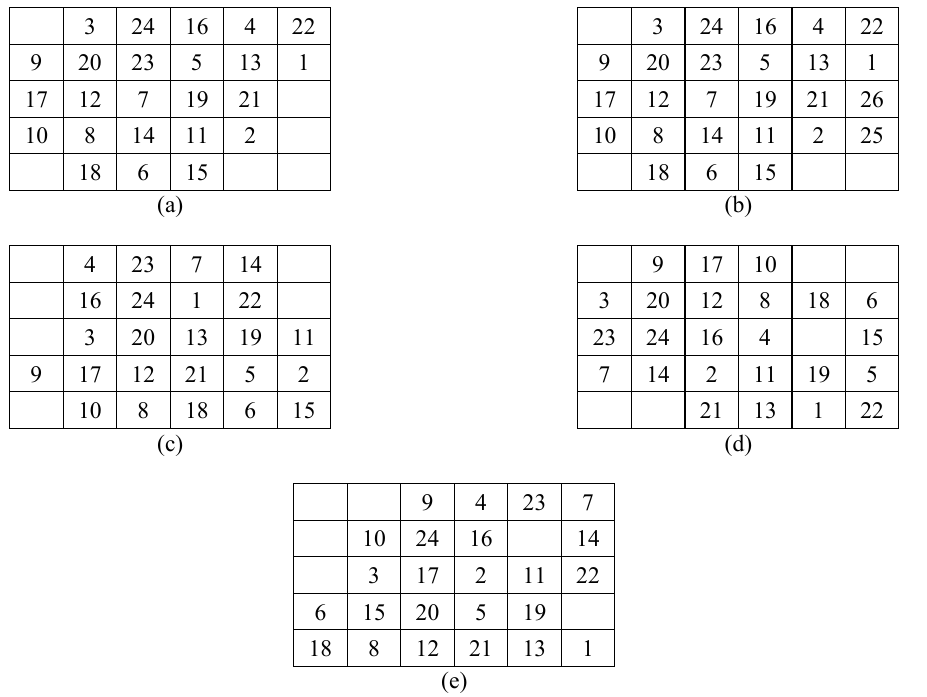
Fig. 9. The best solutions obtained by (a) Mak et al. (1998) (b) El-Baz (2004) (c) Sadrzadeh (2012) (d) Ou-Yang et al. (2013) (e) CPLEX (this paper) for problem 1 Problem